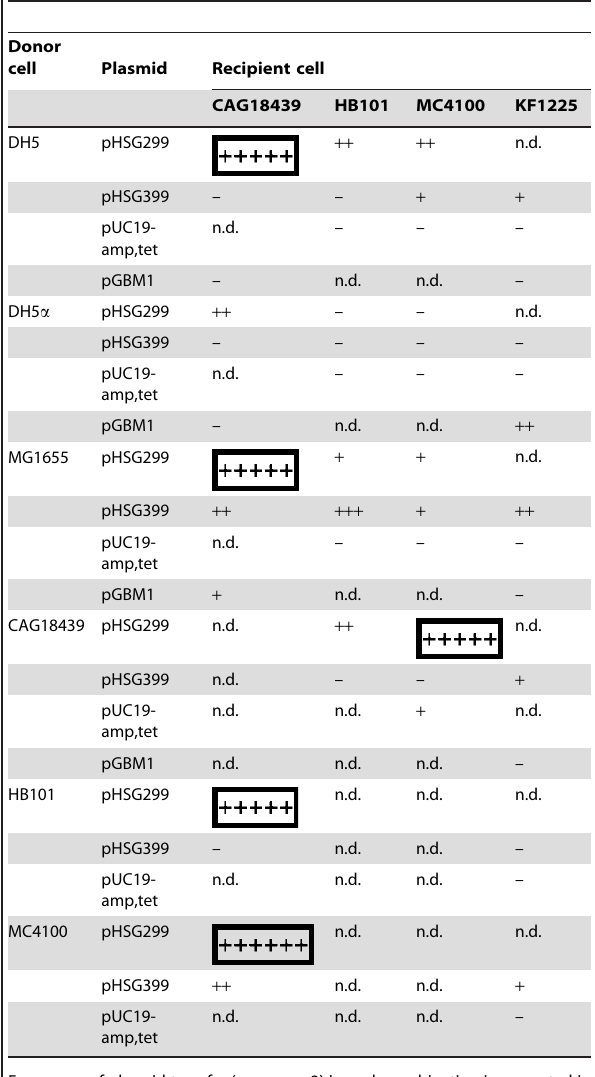
Fig. 1A, addition of DNase I significantly decreased plasmid transfer frequency ( t -test: P , 0.05, n =5). A control experiment confirmed